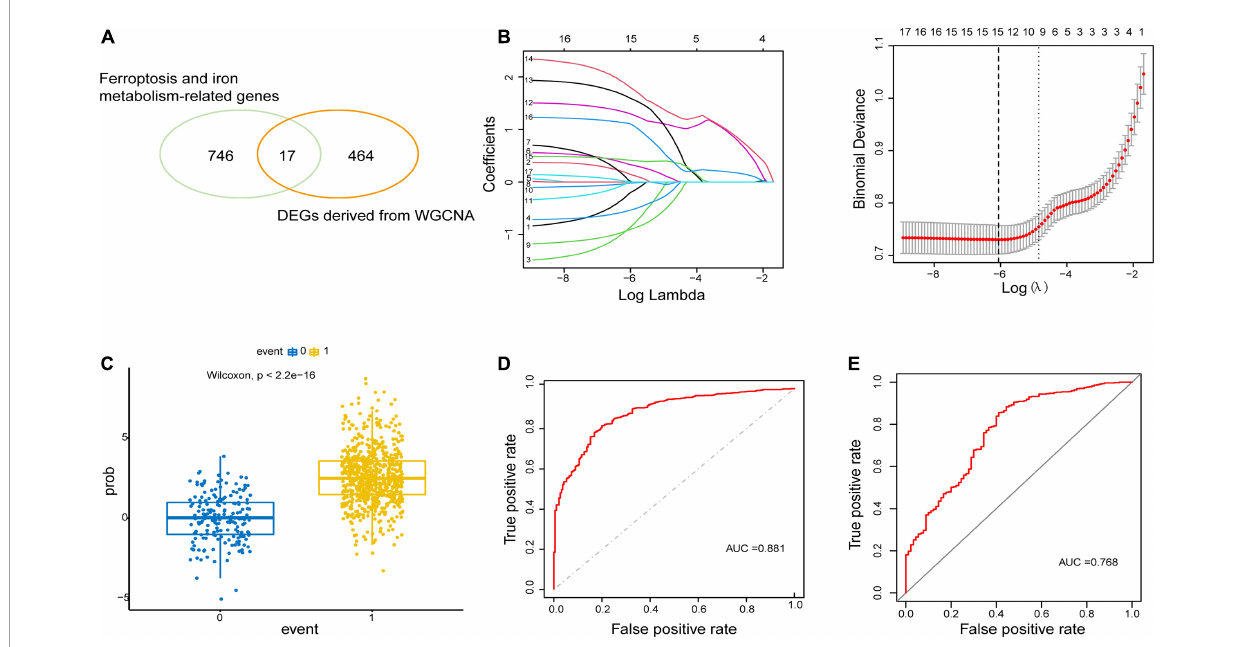
FIGURE4 Construction and validation of LASSO model. (A) 17 overlapping genes were identified between ferroptosis-related genes and ALS-related DEGs derived from WGCNA. (B) Construction of LASSO model. (C) Boxplot: visualization of the predictive property of model. Each dot represented each individual’s predicted score. (D,E) ROC curve analysis of predicting the occurrence of ALS in the primary dataset and secondary